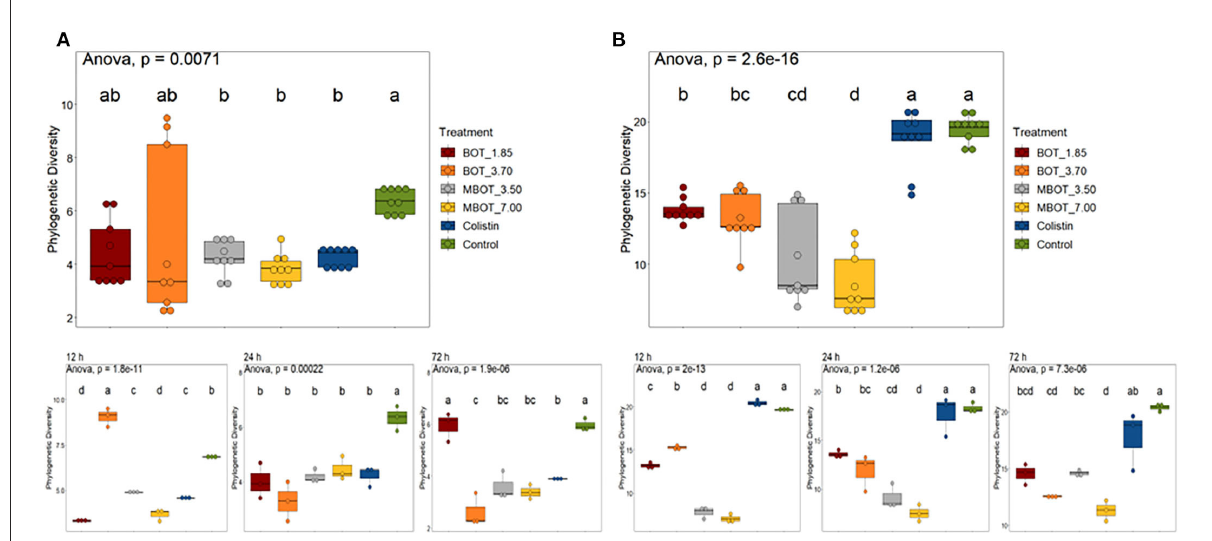
FIGURE2 Box plot of phylogenetic diversity of (A) ileum and (B) colon microbiota during fermentations in the presence of the unprotected BOT, microencapsulated BOT (MBOT), or colistin. The different superscript letters indicate significant differences ( p < 0.05) between any pair of groups calculated by one-way ANOVA with Tukey’s post-hoc test.